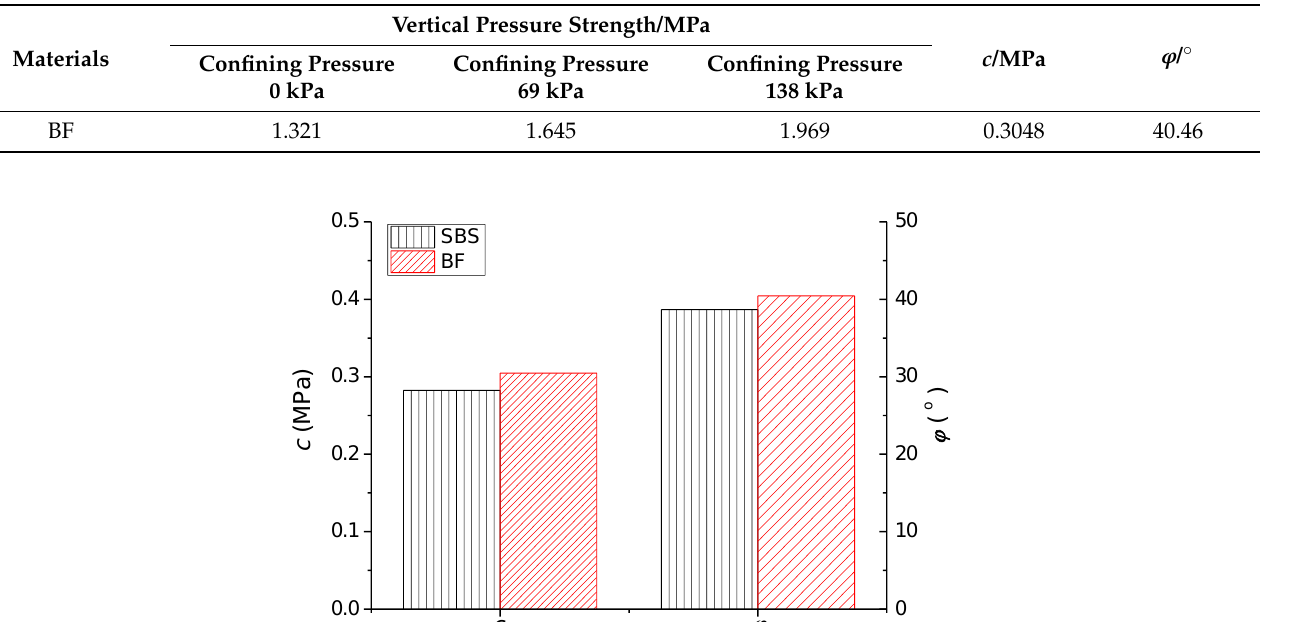
Table 2. Shear parameters of basalt fiber asphalt mixture.